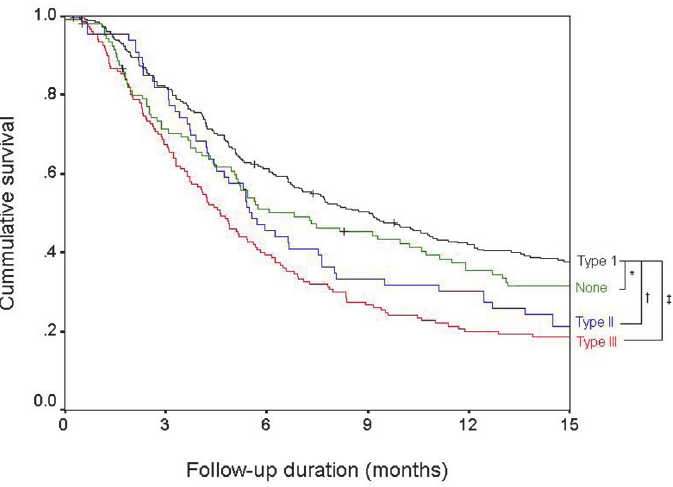
Fig 1. Survival of patients based on the extent of portal vein invasion. There was a significant survival difference based on the extent of portal vein invasion. The extent of PVI was classified as none (green), type-I (segmental or sectoral PVI, black), type-II (left and/or right main PVI, blue), and type-III (main trunk invasion or beyond, red). * P = 0.19; † P = 0.01; ‡ P < 0.01.